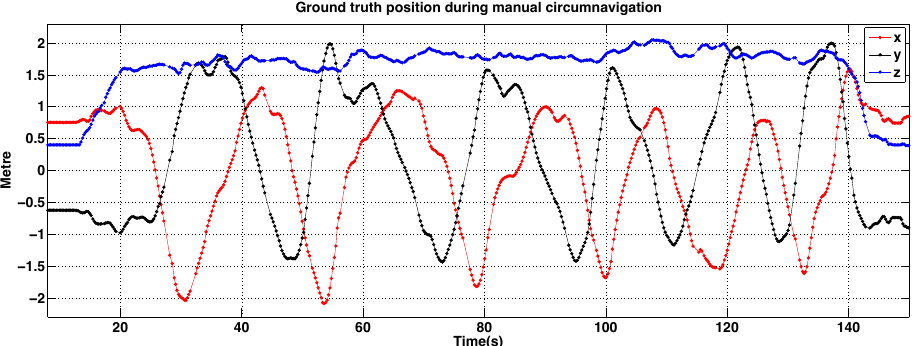
Figure 39. Experimental results for Pilot 2 during manual circumnavigation: position versus time.